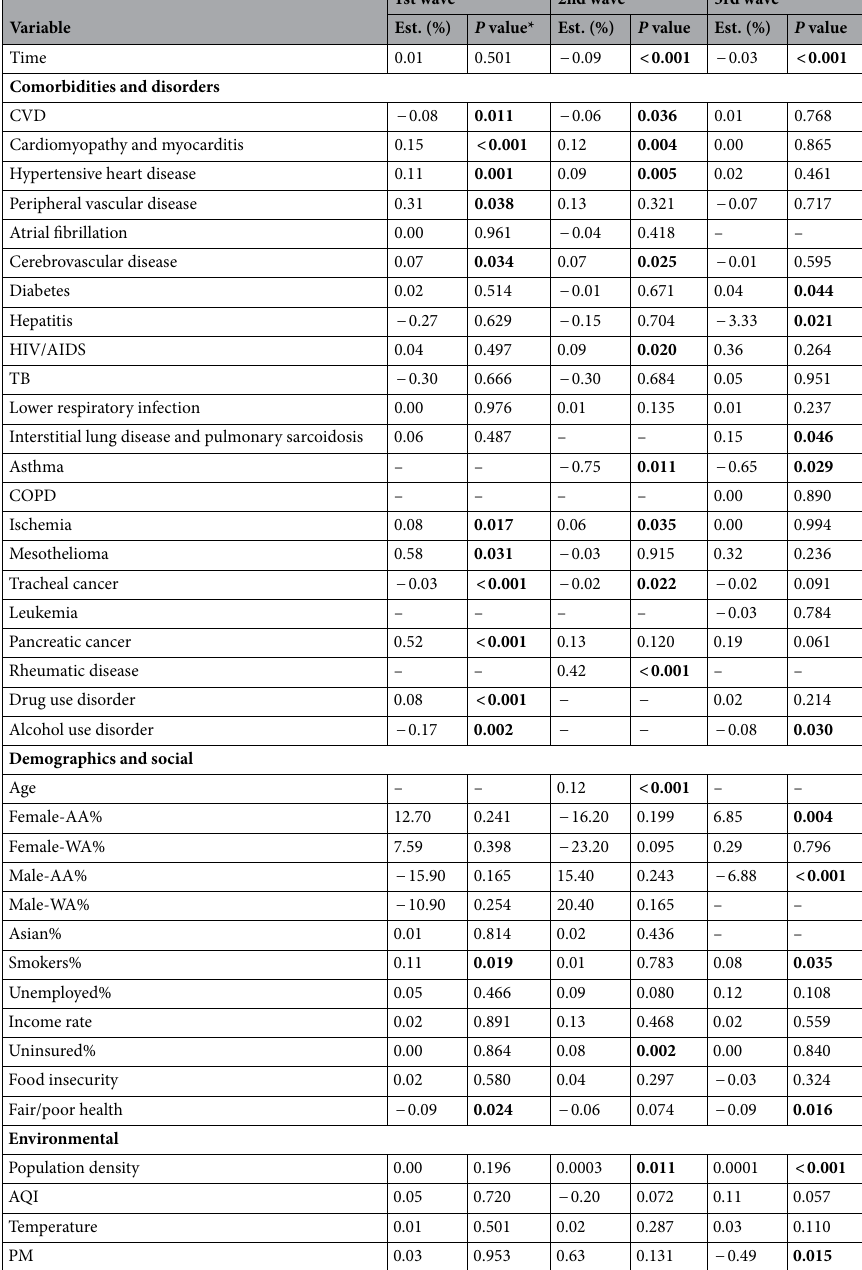
Table 3. Multivariate GEE mo**del’s results. COVID-19 MIR risk factors based on a multivariate longitudinal GEE model (Mar 25 to Nov 12, 2020, USA). * P value < 0.05 is considered as significant. Bold values are statistically significant for P <